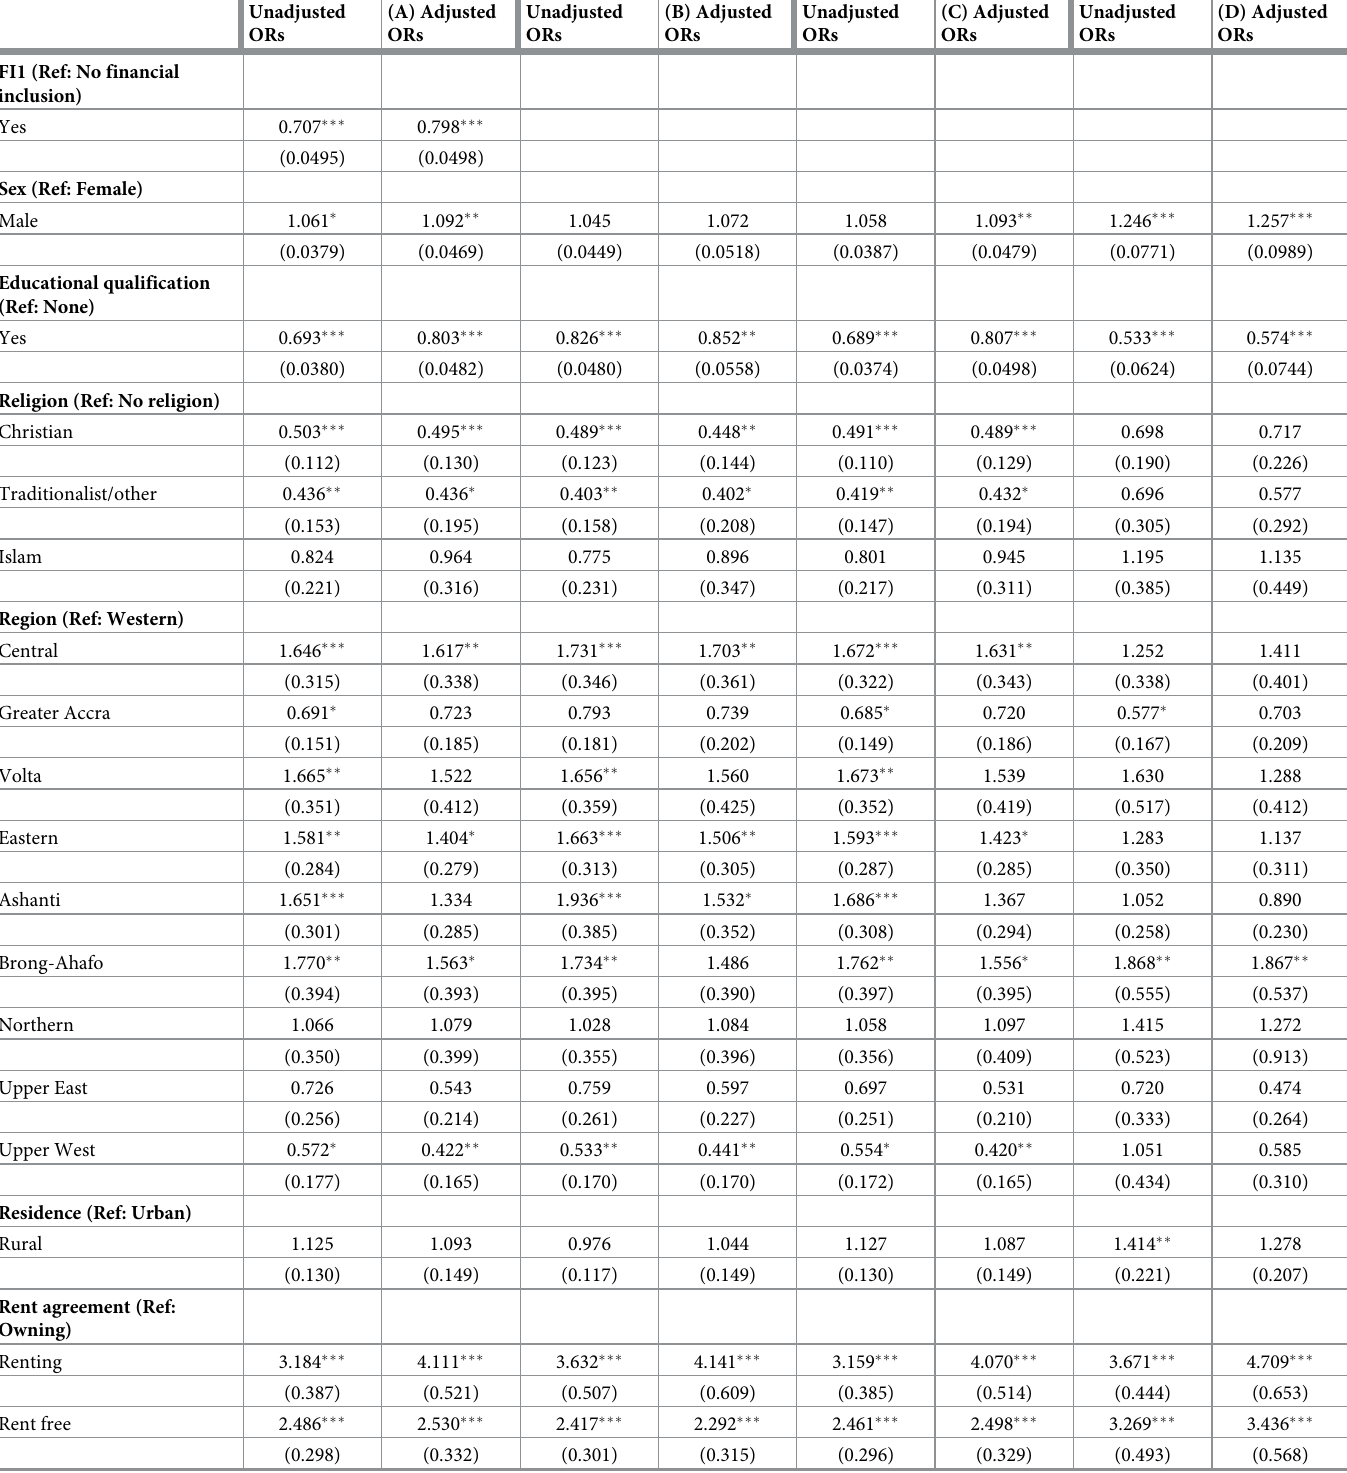
Table 3. Logistic regressions: Effect of financial inclusion on sharing of toilet facilities. Unadjusted